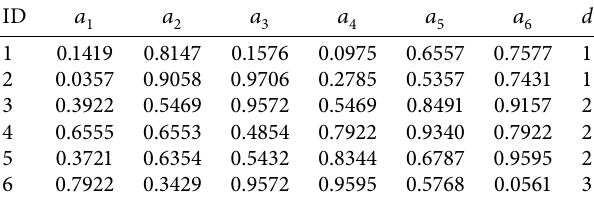
Table 1: An example of decision